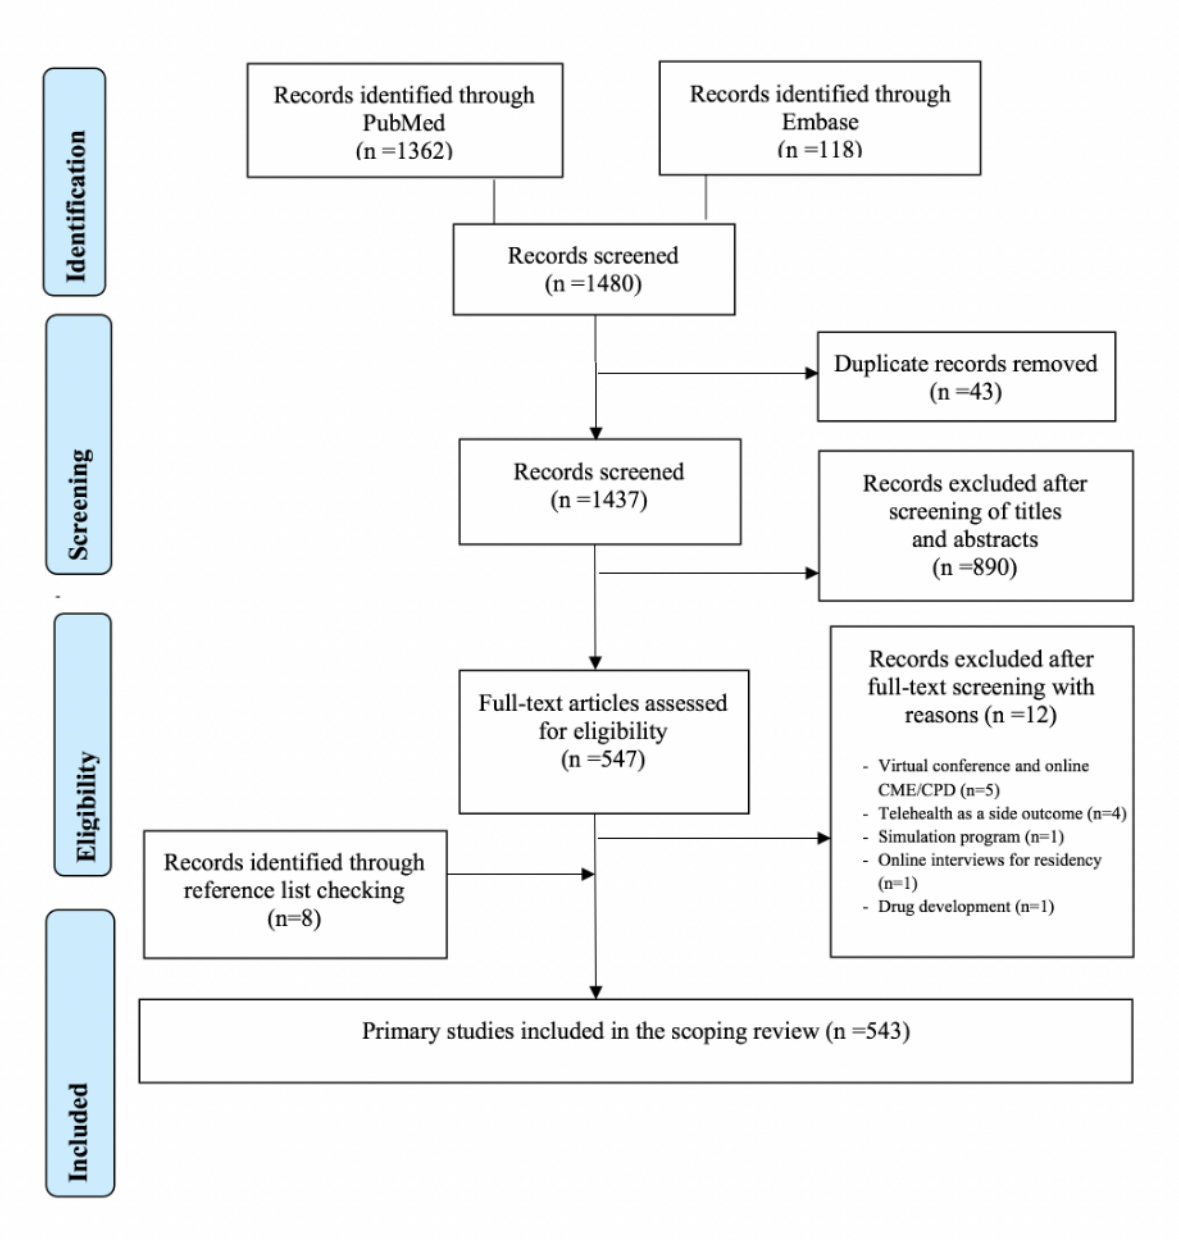
Figure 1. PRISMA 2009 flowchart. PRISMA: Preferred Reporting Items for Systematic Reviews and Meta-Analyses. CME: continuing medical education. CPD: continuing professional